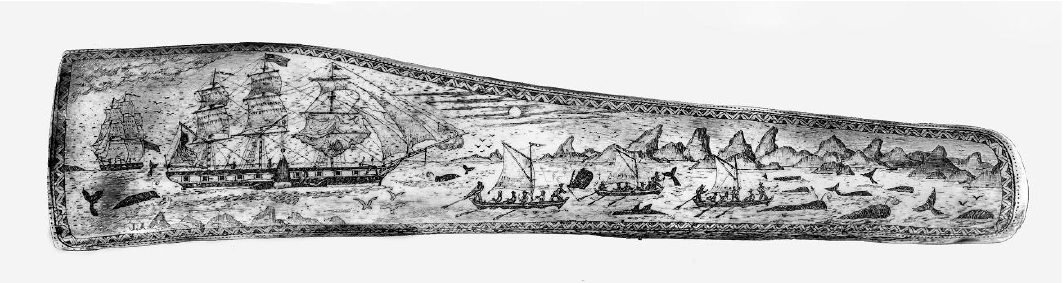
Figure 8. Scrimshaw piece at the Museum of the Sea, Mindelo, offered by the New Bedford Whaling Museum in celebration of the Cape Verdean emigration to the United States of America. Photographed by Hermano Noronha (2019).